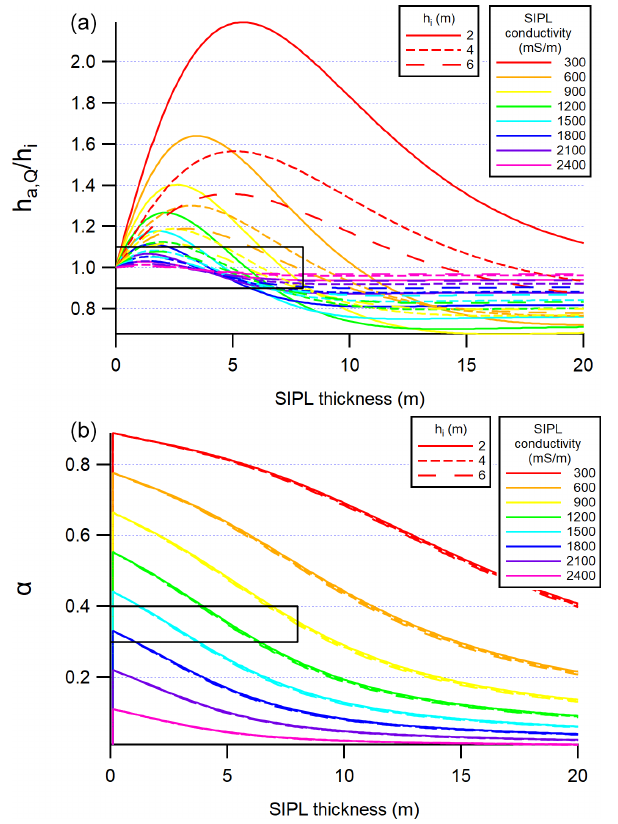
Figure 5. Ratio of h a ,Q /h i ( a ; see Eq. 5a) and α = (h a ,I − h i )/h sipl ( b ; see Eq. 5c) vs. SIPL thickness, at different consolidated ice thicknesses h i between 2 and 6m and different SIPL conductivi- ties between 300 and 2400mSm − 1 . Curves follow from curves in Figs. 3 and 4. Black boxes show the range of h a ,Q /h i and α values resulting from the calibration (Sect. 3.2).